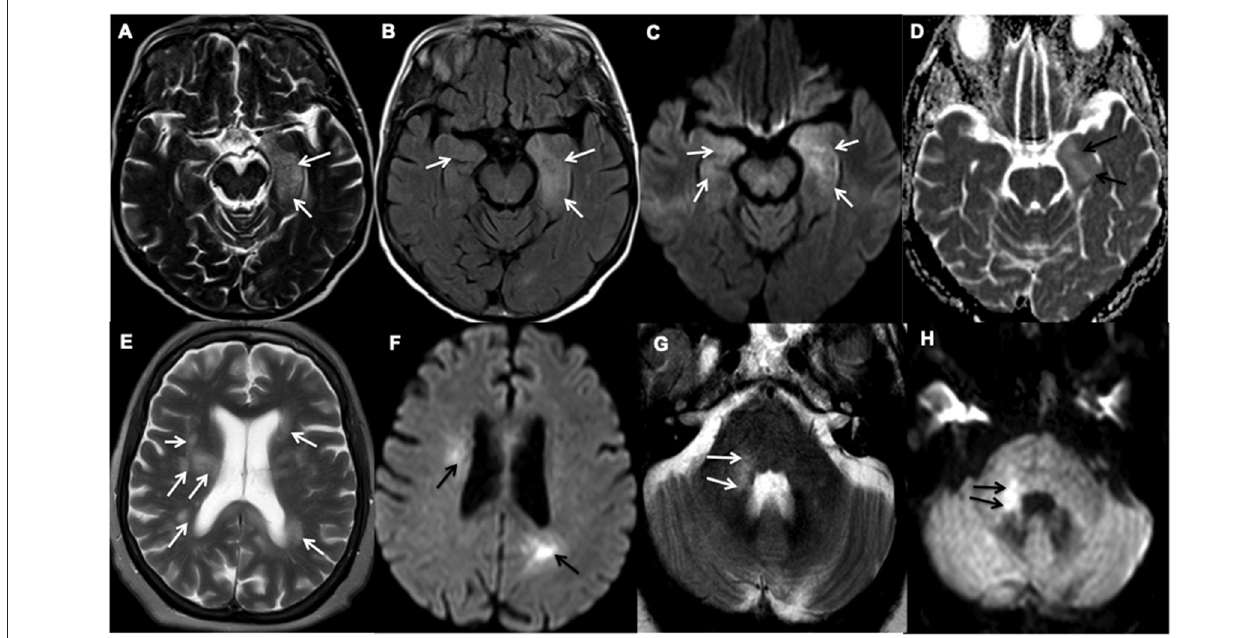
FIGURE 2 | Representative examples of inflammatory encephalopathy. (A–D) Axial MR images of Patient 21 demonstrate limbic encephalitis. (A) T2-weighted and (B) Fluid attenuated inversion recovery (FLAIR) imaging demonstrate hyperintensity in both medial temporal lobes, but predominantly in the left amygdala and hippocampus (white arrows), (C) Diffusion-weighted imaging (white arrows) and (D) Apparent diffusion coefficient (ADC) show corresponding partial diffusion restriction (black arrows). (E–H) Axial MR images of Patient 27 demonstrate acute demyelinating encephalomyelitis. (E) T2-weighted imaging demonstrates patchy and asymmetric white matter hyperintensities within the periventricular and subcortical regions and (G) right middle cerebellar peduncle (white arrows). (F,H) Diffusion-weighted imaging shows corresponding high diffusion signal (black arrows).